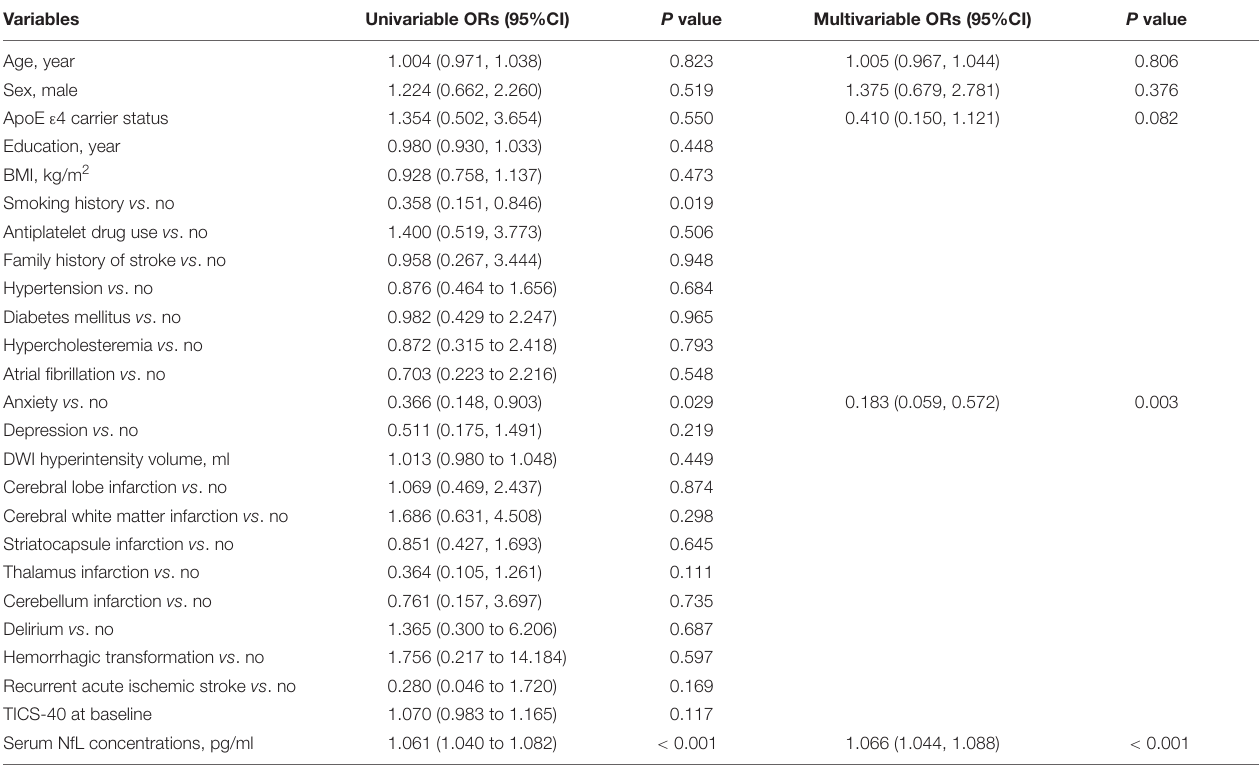
FIGURE 2 | Serum NfL concentrations in patients with and without a longitudinal cognitive decline. (A) Serum NfL concentrations are significantly higher in the progression group in comparison with the stable group. Unpaired t test. (B) Serum NfL can differentiate the progression group from the stable group. Receiver operating characteristic analysis. Cutoff value = 79.31 pg/ml. TABLE 2 | A logistic regression model to evaluate the risk factors for cognitive decline as indicated by decreased TICS-40 scores in patients with subjective cognitive impairment